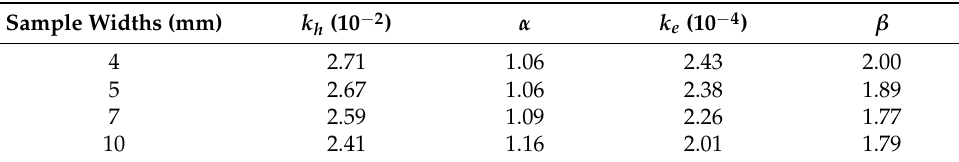
Table 2. Coefficients k h , k e , α , and β approximating the specific loss characteristics of electrical steel sheets M270-35A as a function of the width of the sample cut with a laser for the frequency range 5–50 Hz and the induction range up to 0.6 T.